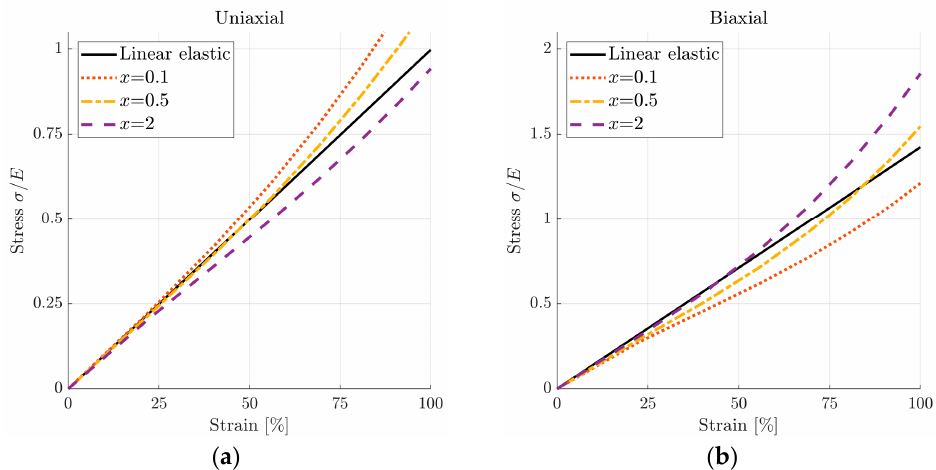
Figure 3. Comparison of a hyperelastic material model to linear-elastic for a simple one-element case in ( a ) uniaxial loading and ( b ) biaxial loading.